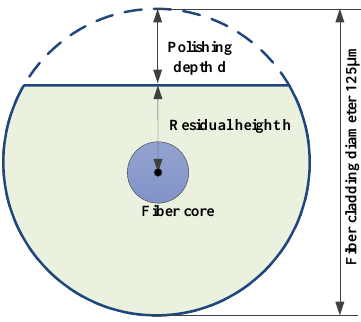
Figure 1. Sectional schematic view of a D-shaped fiber.